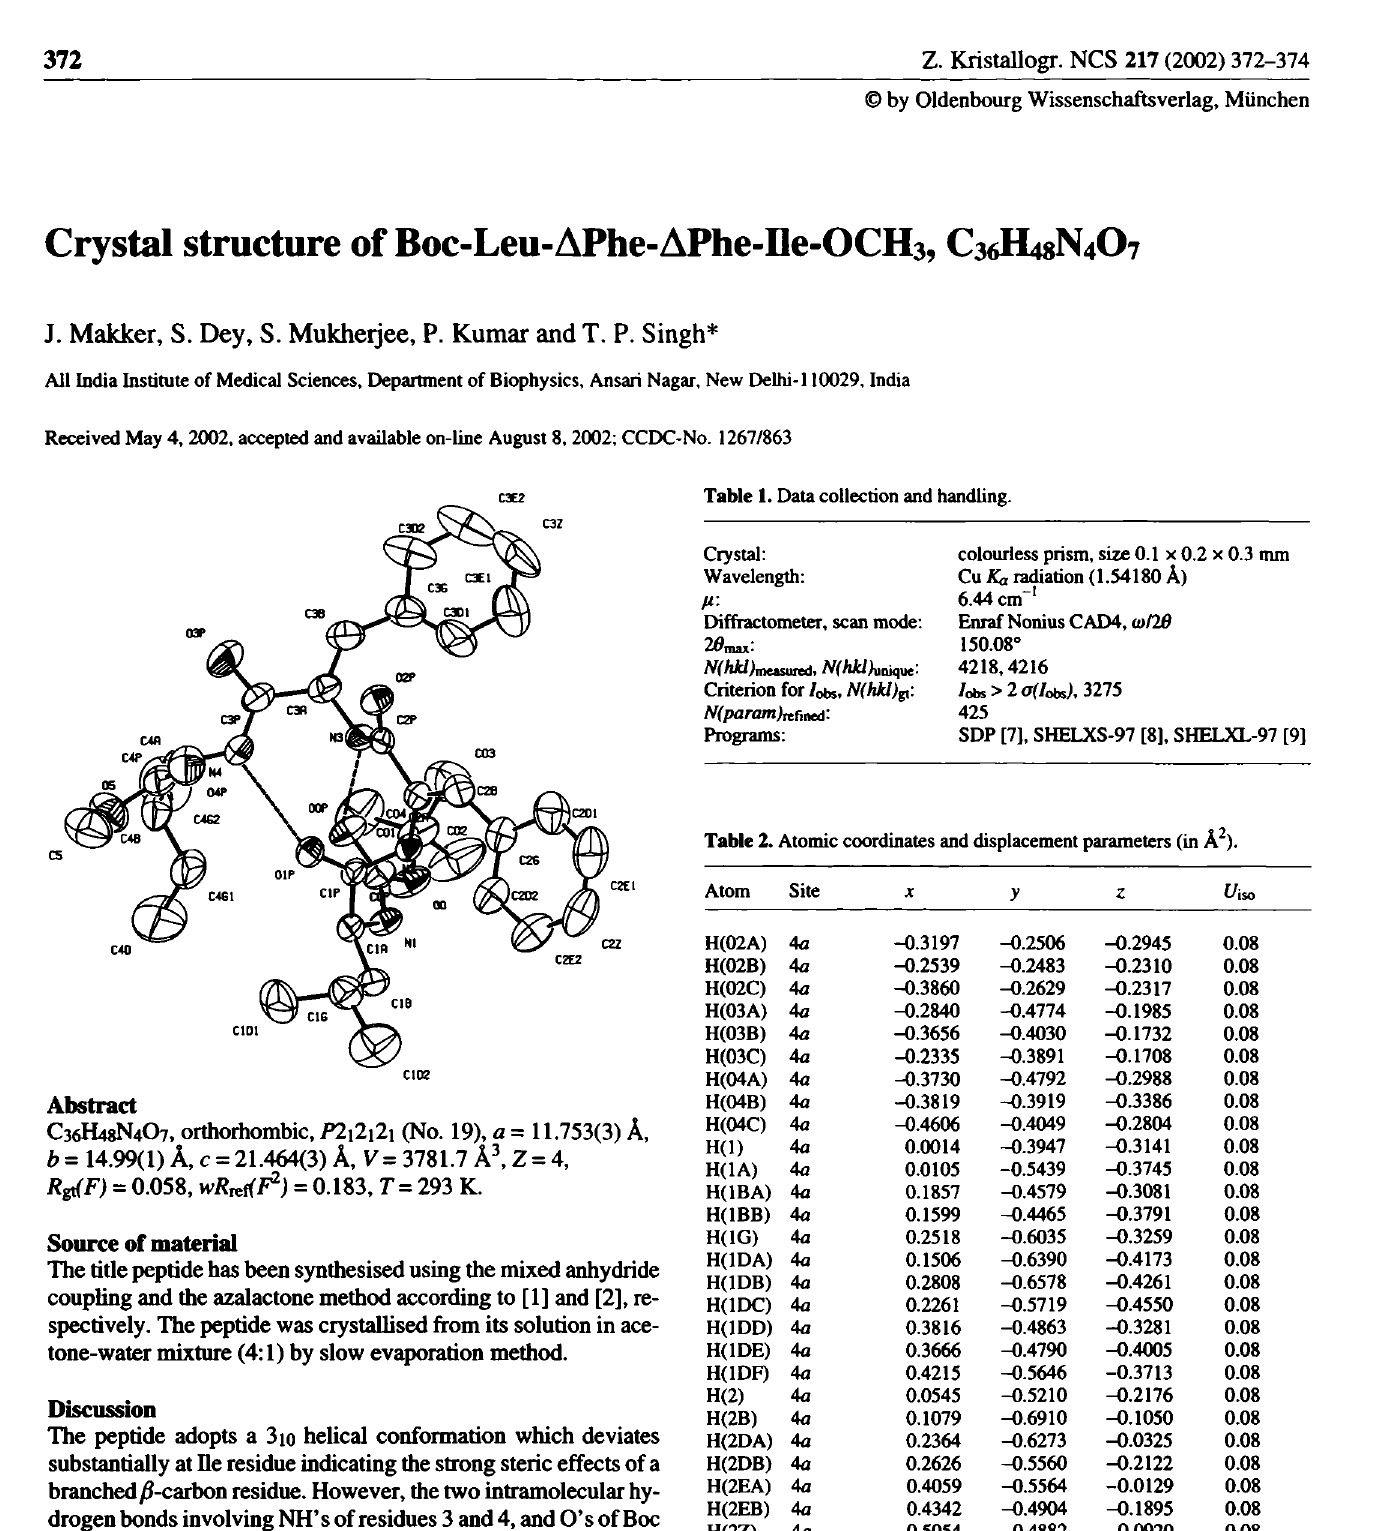
Table 2. Atomic coordinates and displacement parameters (in Â 2